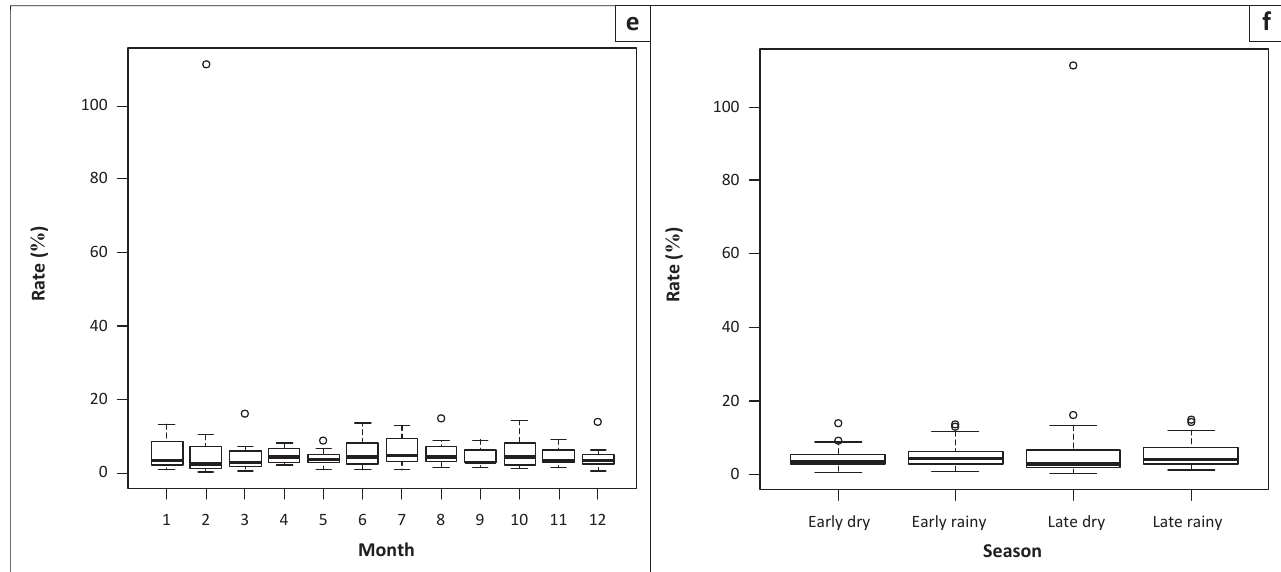
FIGURE 1-A2 (Continues...): Monthly and seasonal rate of throughput, slaughter of pregnant animals and foetal wastage for cattle, Minna Metropolitan Abattoir, Nigeria, during 2001–2012. (a) Monthly throughput for cattle, (b) seasonal throughput for cattle, (c) monthly slaughter of pregnant cattle, (d) seasonal slaughter of pregnant cattle, (e) monthly rate of foetal wastages in cattle and (f) seasonal rate of foetal wastages in cattle.